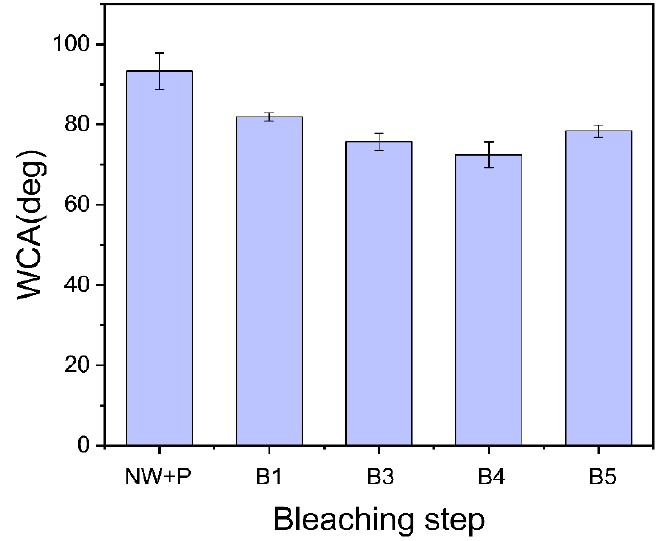
Figure 10. Water contact angles of CW specimens.